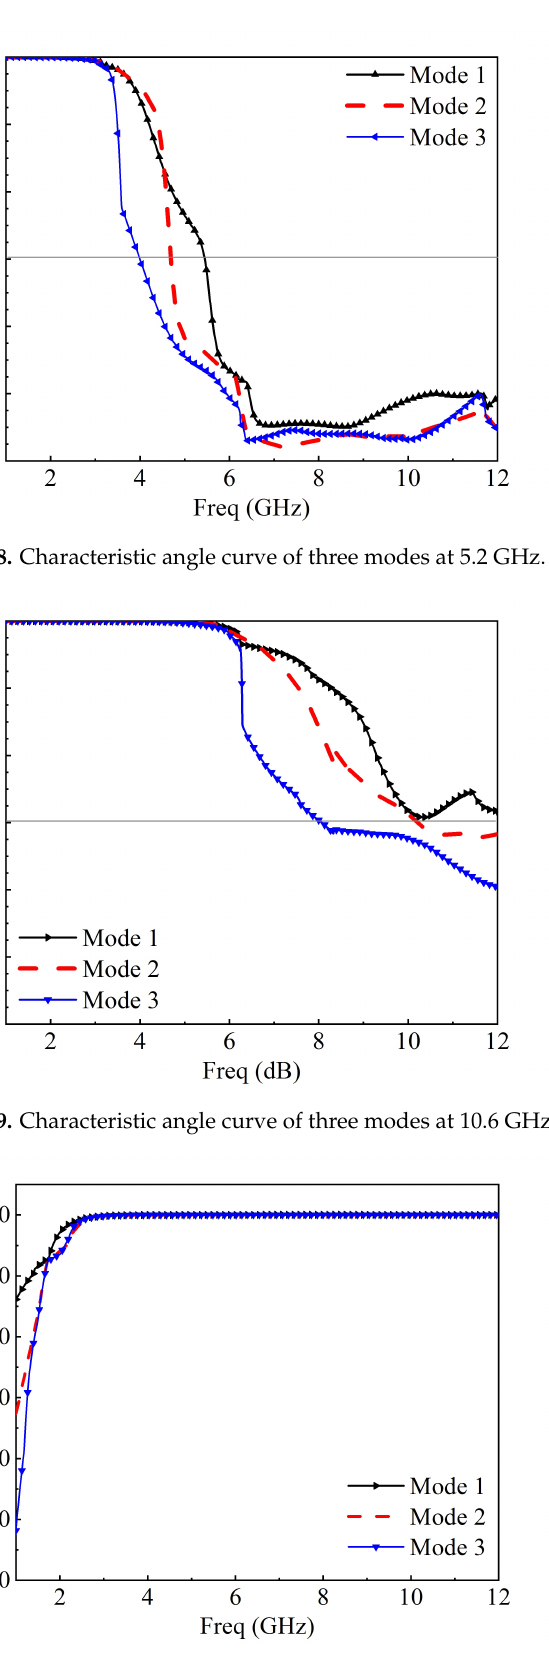
Figure 10. Eigenvalues of three modes at 5.2